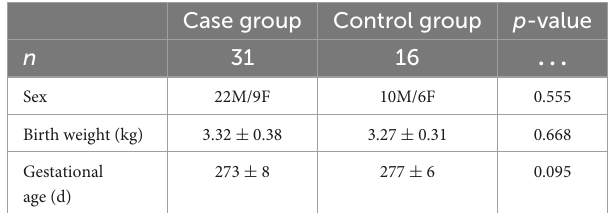
TABLE 1 Baseline characteristics of study